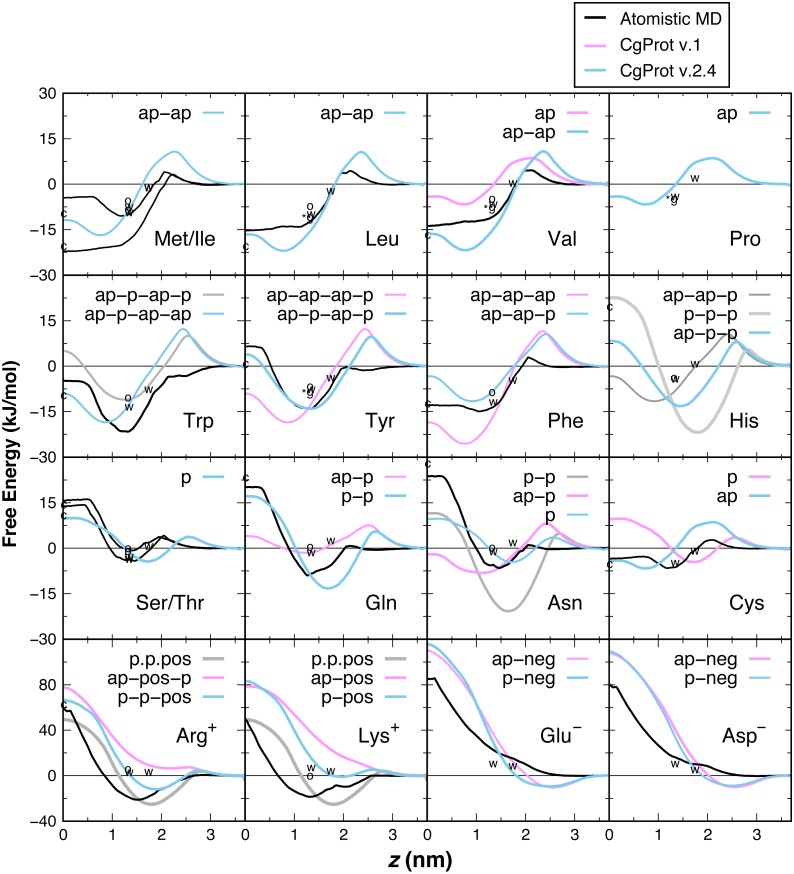
PMF insertion profiles for mass centers of sidechain analogs relative to the bilayer center.PMFs are set to zero in water. PMFs from atomistic simulations are compared in black (MacCallum, Bennett & Tieleman, 2008). The bonding of CG sites is depicted for polar (p), apolar (ap), positive (pos) and negative (neg) types. Shorter bonds (.) were tested for Lys/Arg. Alternate sidechain descriptions shown in gray are not recommended. Various experimental data are plotted relative to zero for glycine. For sidechain analogs, the water-cyclohexane transfer energy is marked c at z = 0 and the water-octanol energy is marked o at z = 1.3 nm (Radzicka & Wolfenden, 1988). ΔGcor for the octanol solvation of a sidechain in a peptide occluded by moderate-sized neighbors is marked w at z = 1.3 nm (Wimley, Creamer & White, 1996). ΔGGXG for a fully exposed sidechain in GGXGG peptide is marked *g at 1.3 nm for Leu, Val, Pro and Tyr. The sidechain solvation energy for a WLXLL peptide at the POPC interface is marked w at z = 1.7 nm (Wimley & White, 1996).